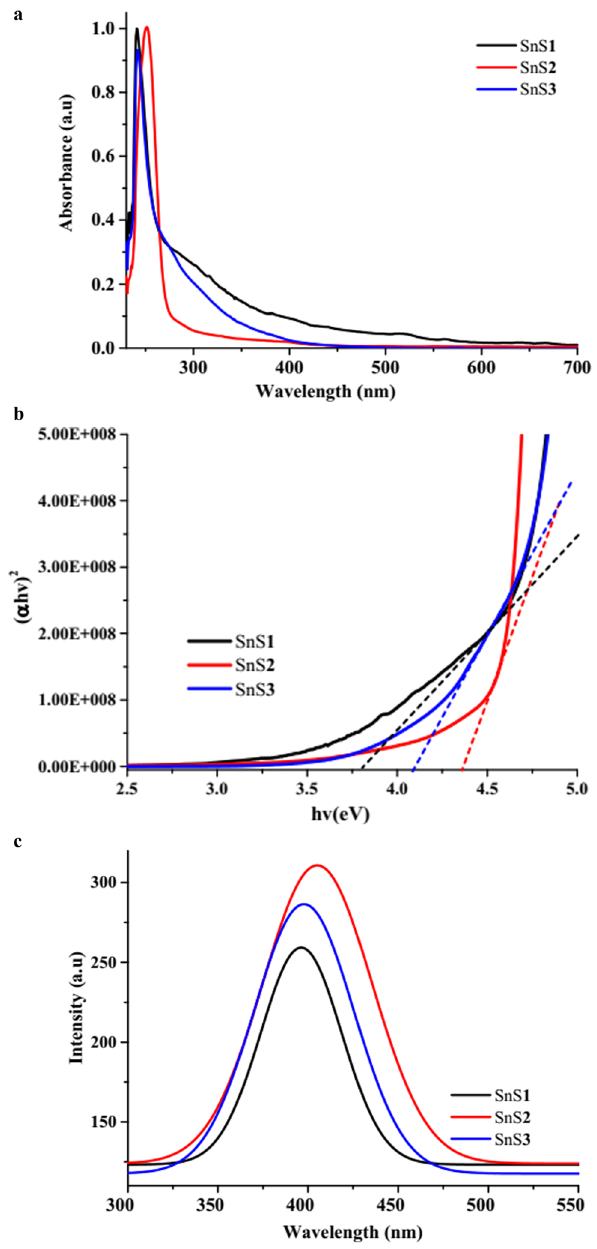
Figure 3: ( a ) SnS nanoparticles absorption spectra; ( b ) Tauc plots; and ( c ) emission